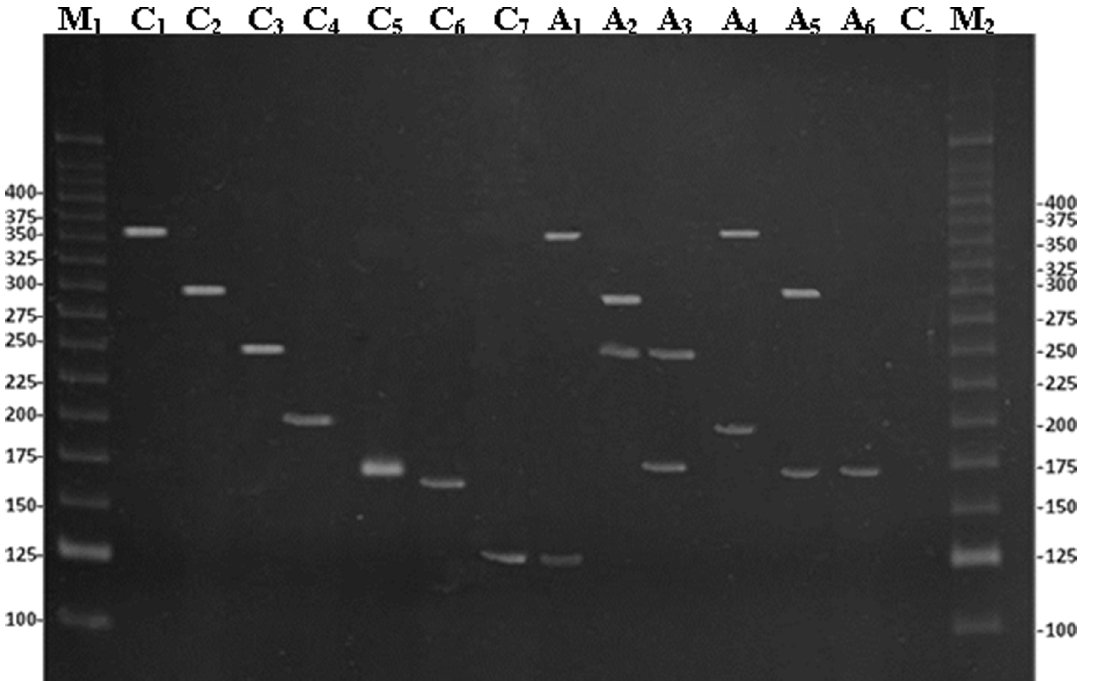
Figure 1. Electrophoretic analysis of the amplified fragments by using a multiplex polymerase chain reaction in 8% polyacrylamide gel stained with ethidium bromide. Lane C 1 : control of Chlamydia trachomatis (361 base pairs-bp); lane C 2 : control of Treponema